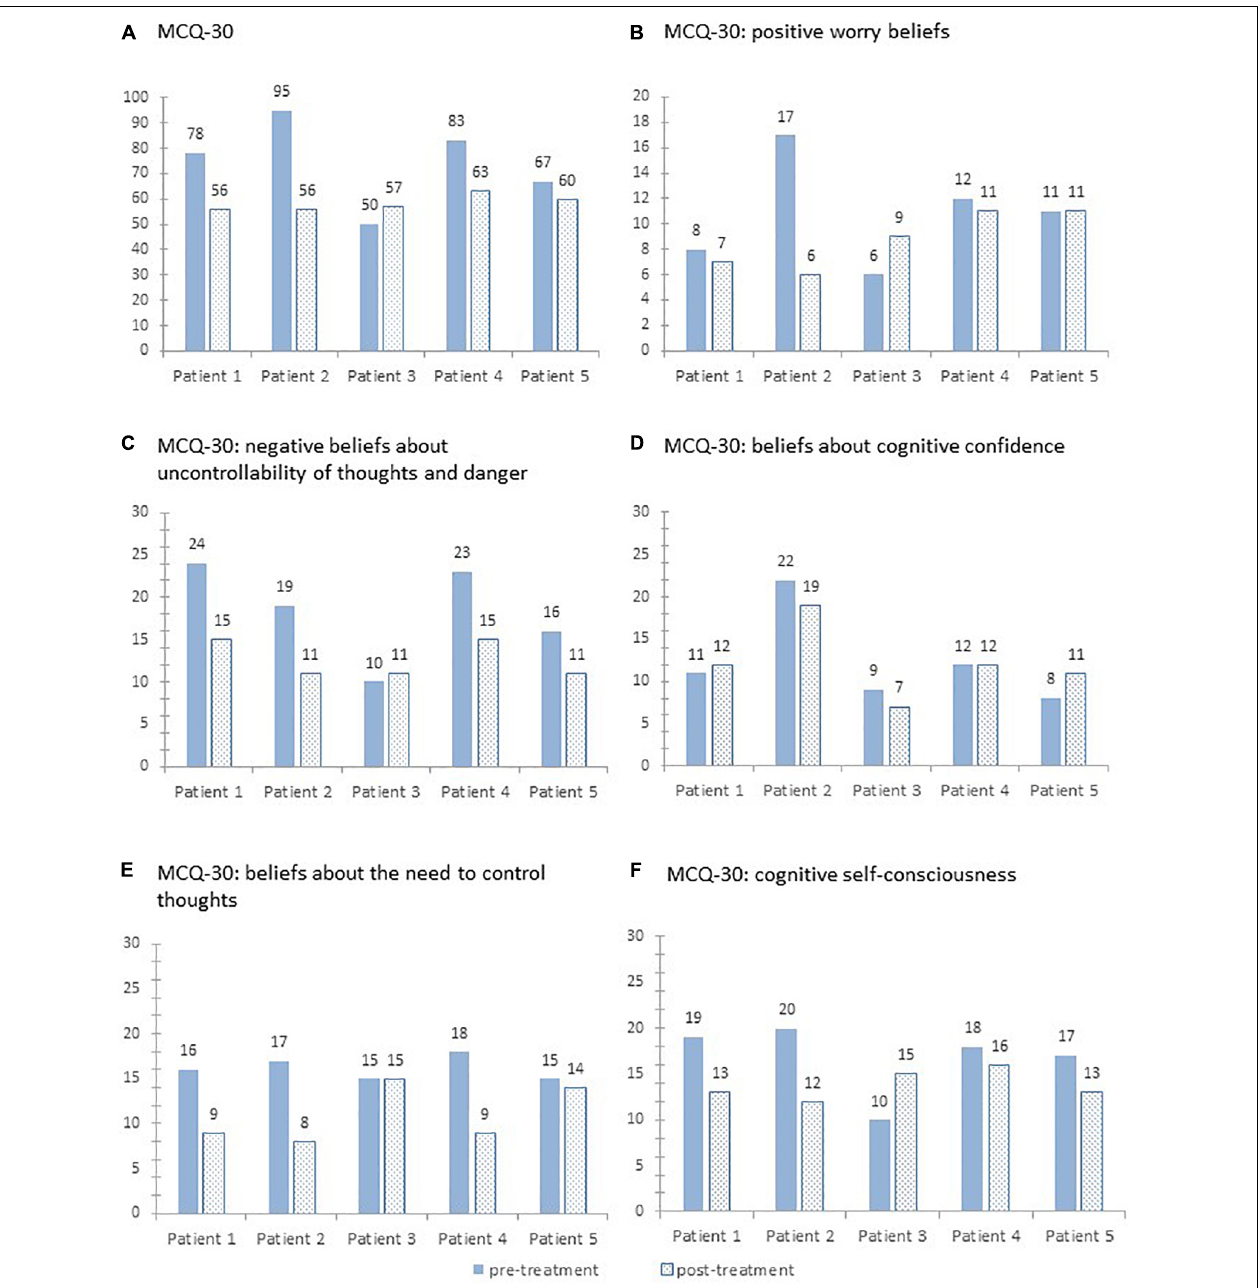
FIGURE 2 | Sum scores on the Metacognitions Questionnaire-30 (A) and its five subscales (B–F) pre- and post-treatment for each